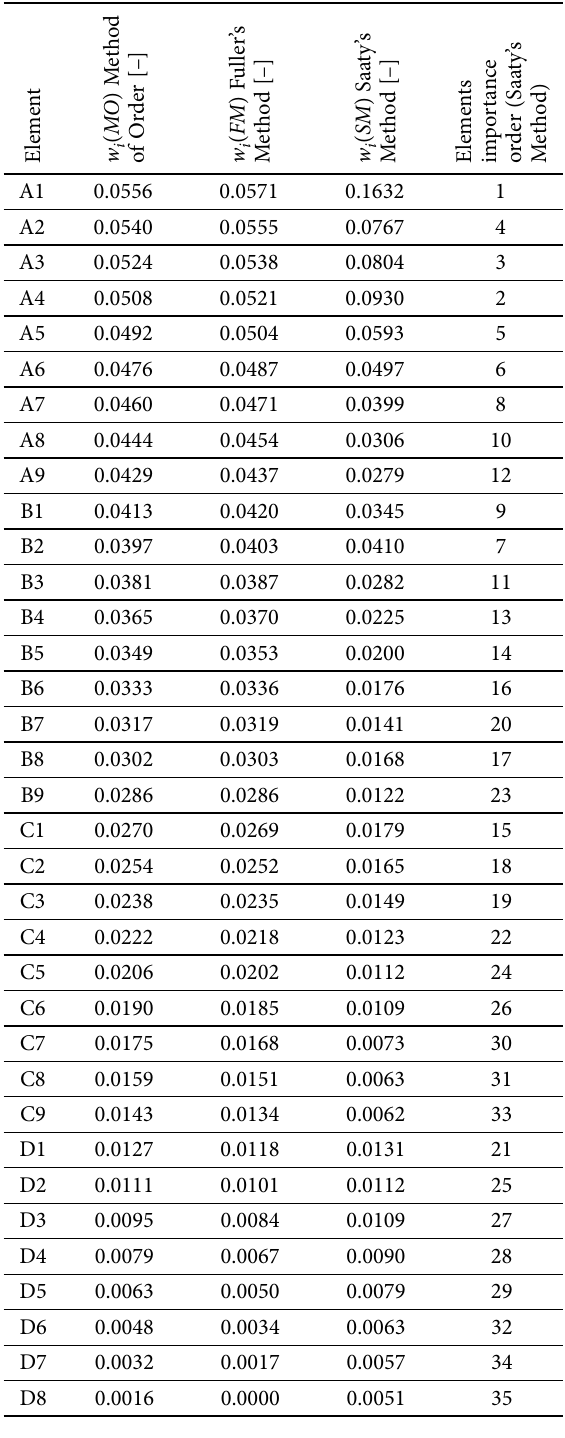
Table 1. Estimation of weights of elements of Internet presentations in the way of different methods; final order determined by Saaty’s Method